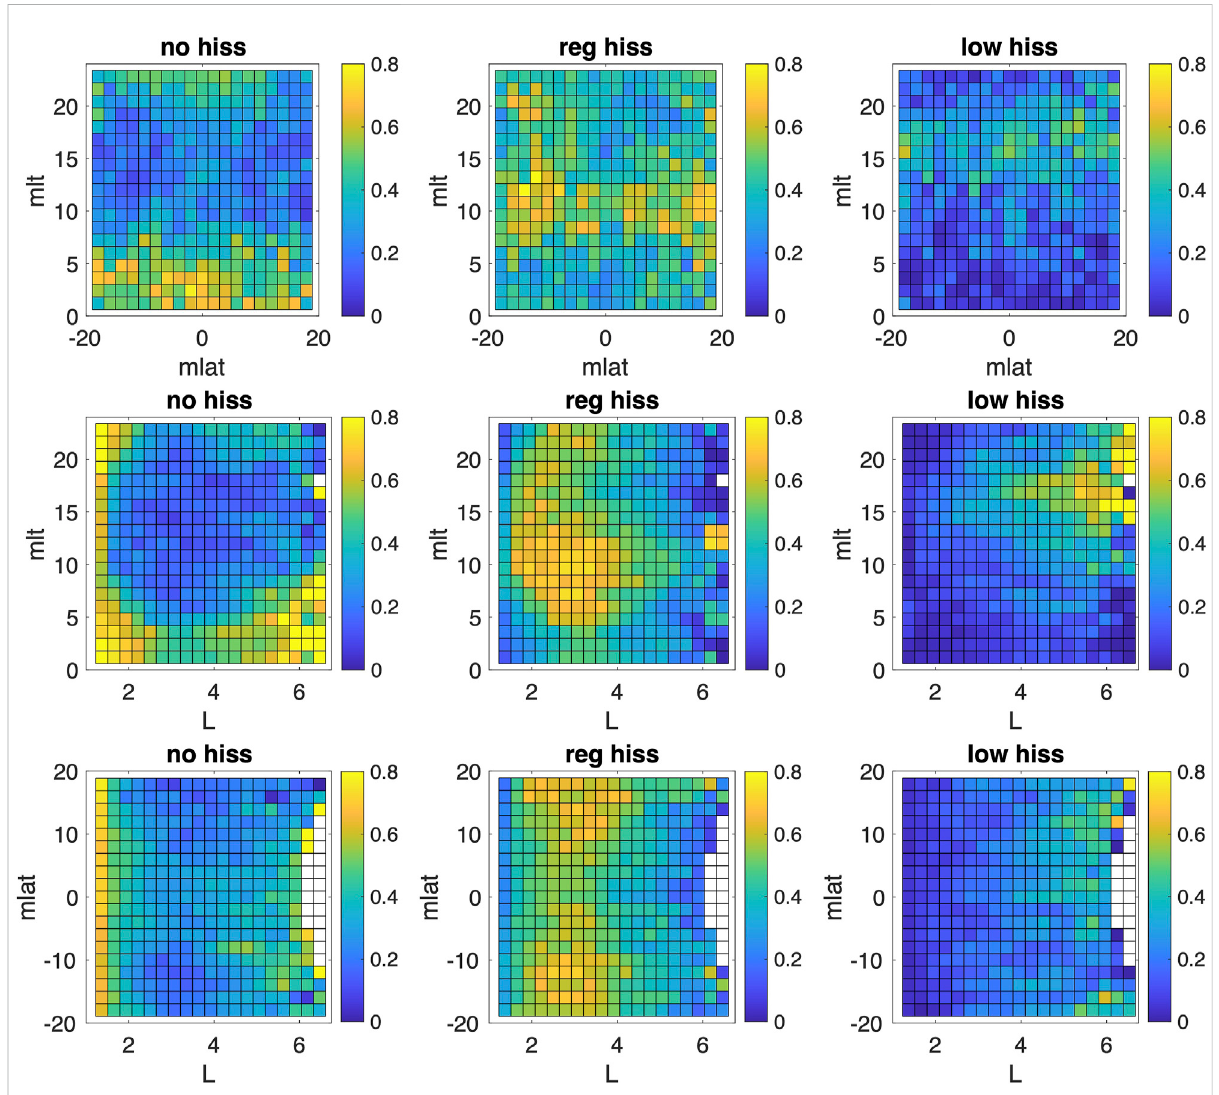
FIGURE 2 SameasinFigure1butnormalizedbythetotalnumberofspectralshapesforallthreeclassescombinedineachbin;whitecolorcorrespondsto no data in the